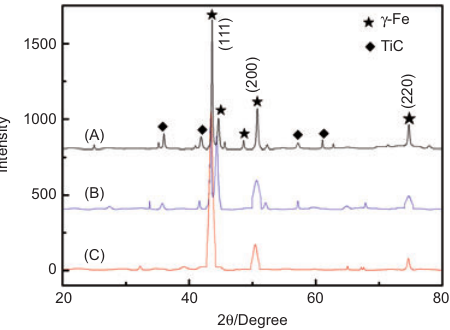
Figure 2 XRD patterns of 5 wt. % TiC/316L composites: (A)